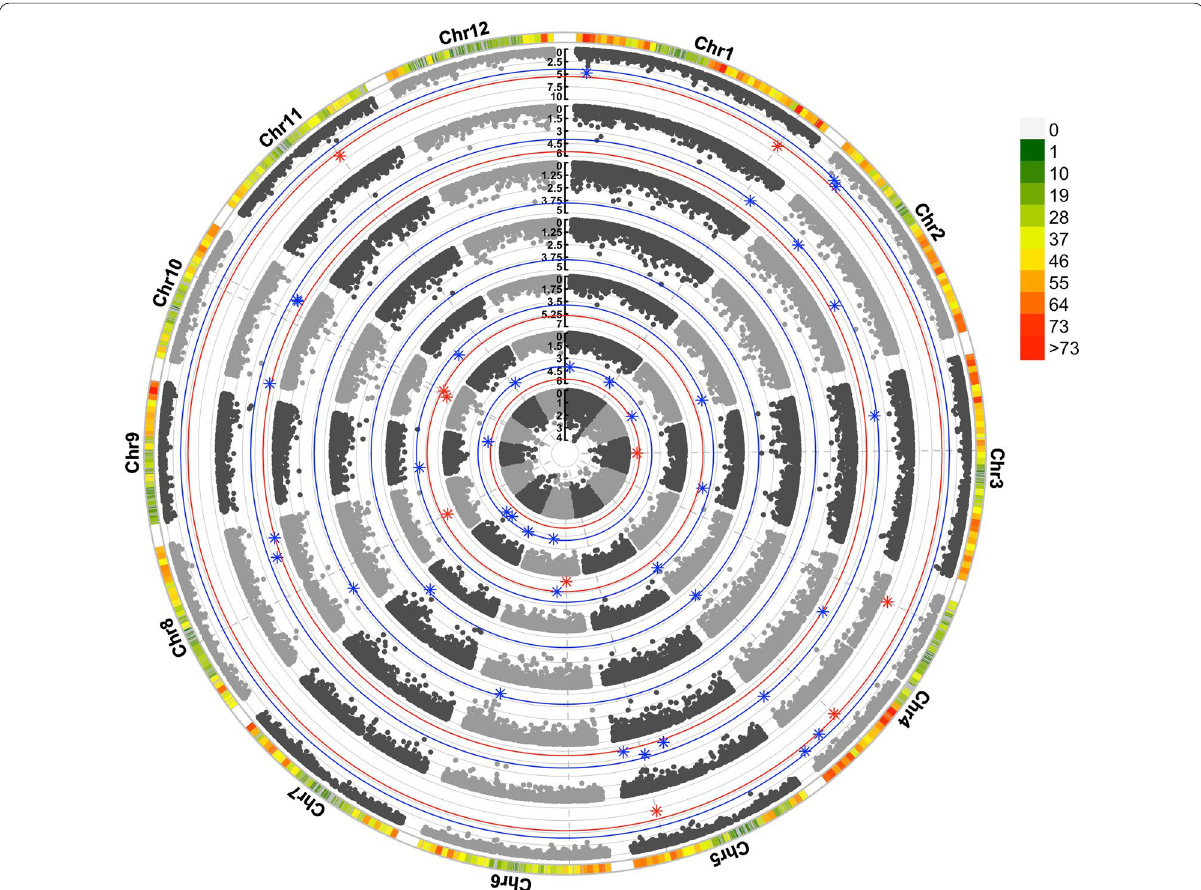
Fig. 5 Circular Manhattan plot depicting significant marker trait associations for various traits moving from center towards the periphery plant height, culm thickness, panicle length, number of primary branches per panicle, grain length, grain width and hundred grain weight where red and blue lines represent p -value 1e 6 (Bonferroni threshold) and 1e 4 (threshold in current study), ≤ − −